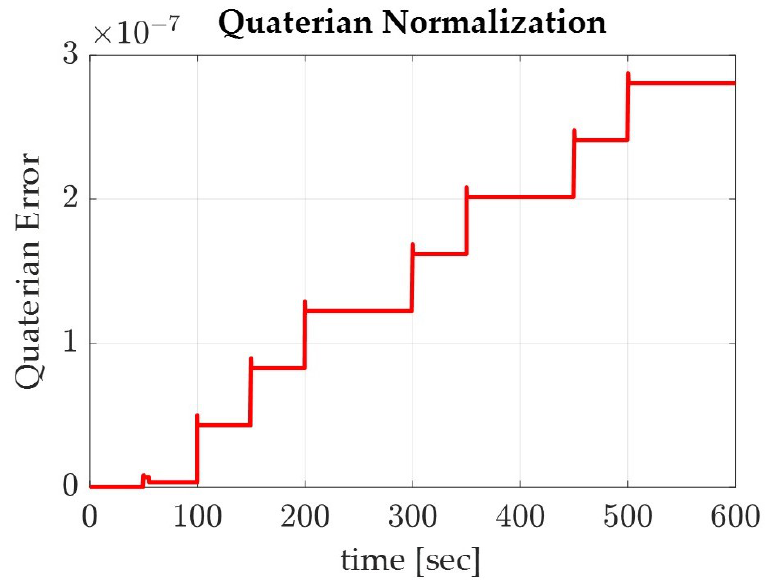
Figure 9. Graph of the normalized quaternions for the spacecraft on the sinusoidal